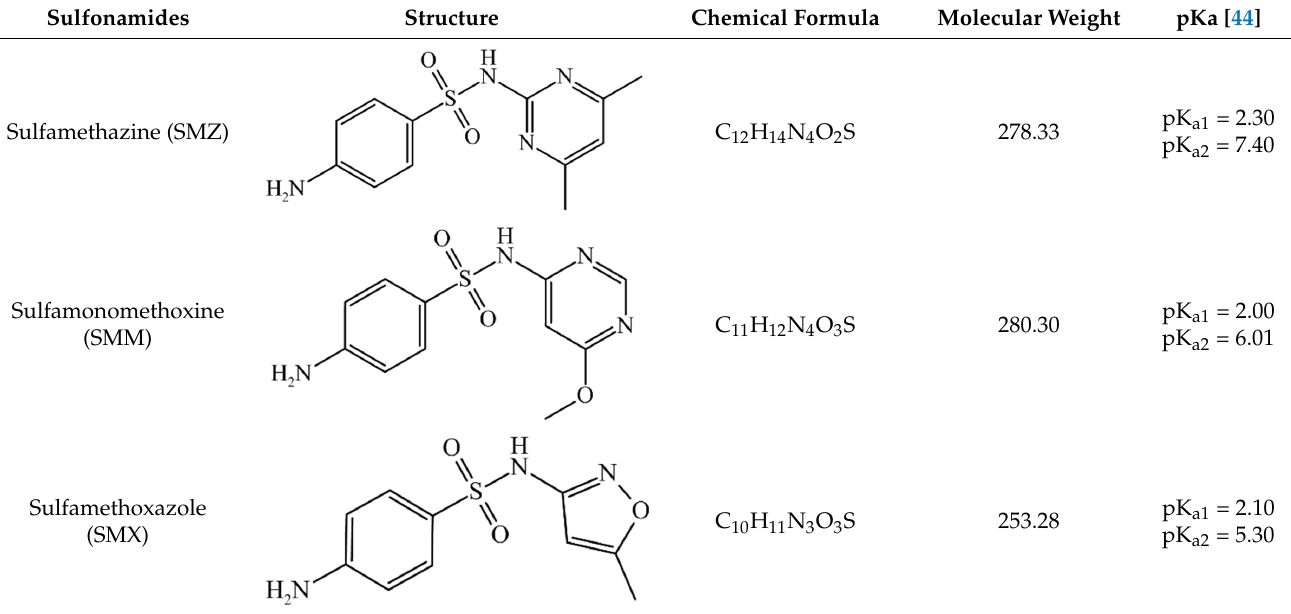
Table 3. Structure and physicochemical parameters of the sulfonamides used.